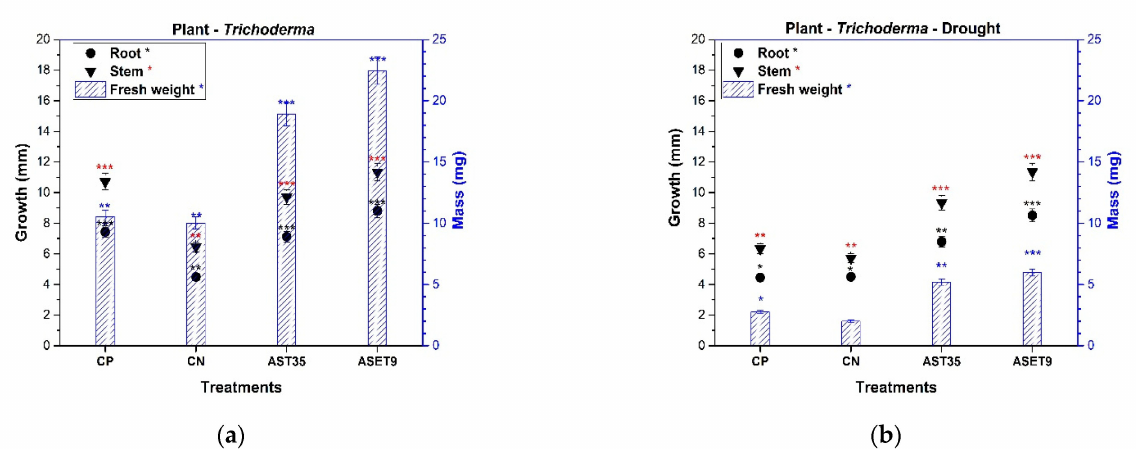
Figure 5. Effect of Trichoderma strains in the in vivo plant growth promotion assay of Sorghum bicolor plants in soil with alkaline salinity and drought mitigation. ( a ) Plant–microorganism interaction under endemic agriculture conditions. ( b ) The effect of microorganisms on mitigating stress caused by drought. The means marked with ***, ** and * are significantly different in each item designated for p < 0.05 in Tukey’s